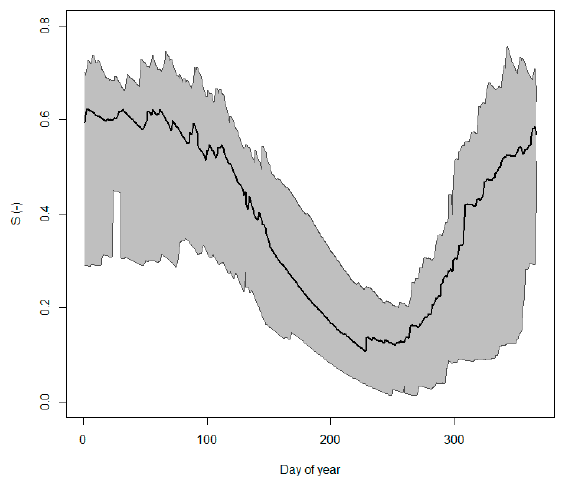
Figure 3. Evolution of the seasonal variation of normalized soil moisture, S , over the year. Thick line indicates mean values, and gray zone indicates 5 to 95% quantiles.